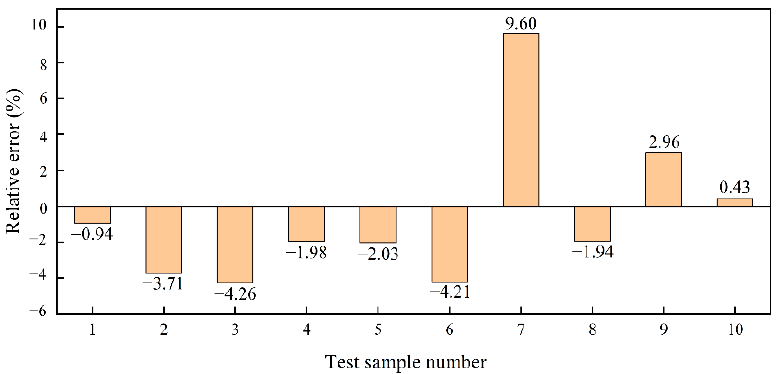
Figure 9. Relative error between predicted and measured values.